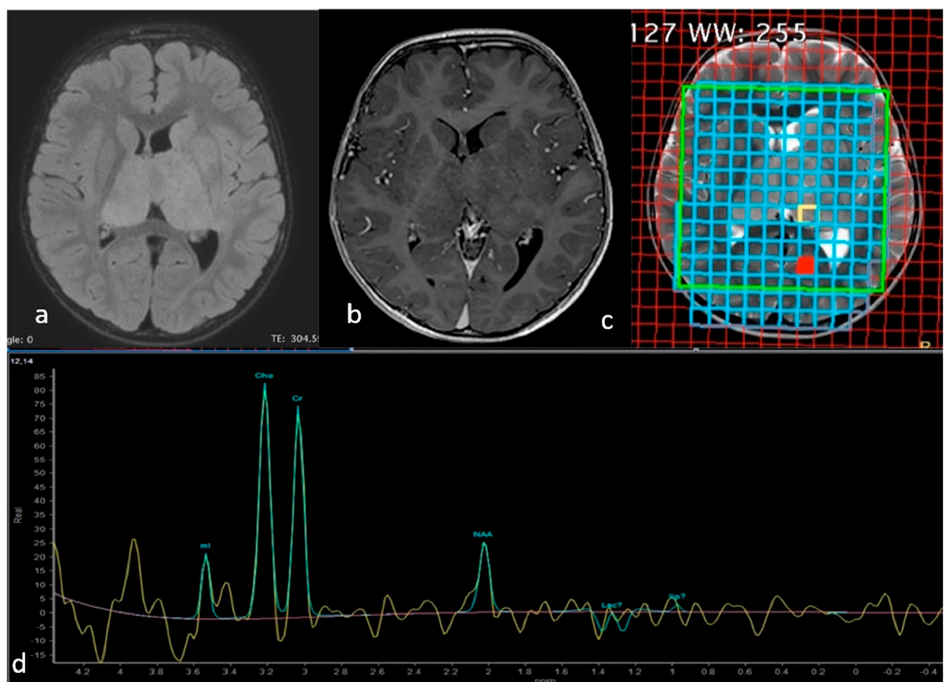
Figure 2. Axial FLAIR ( a ), Gadolinium-enhanced T1-weighted ( b ) and T2-weighted ( c ) MR images showing the lesion involving both thalami and head of caudate nuclei with no evident contrast enhancement. The spectrum ( d ) at the level of the yellow square in the left pulvinar corresponded to the area of highest cholin peak, where NAA was markedly decreased, chosen as the biopsy target.